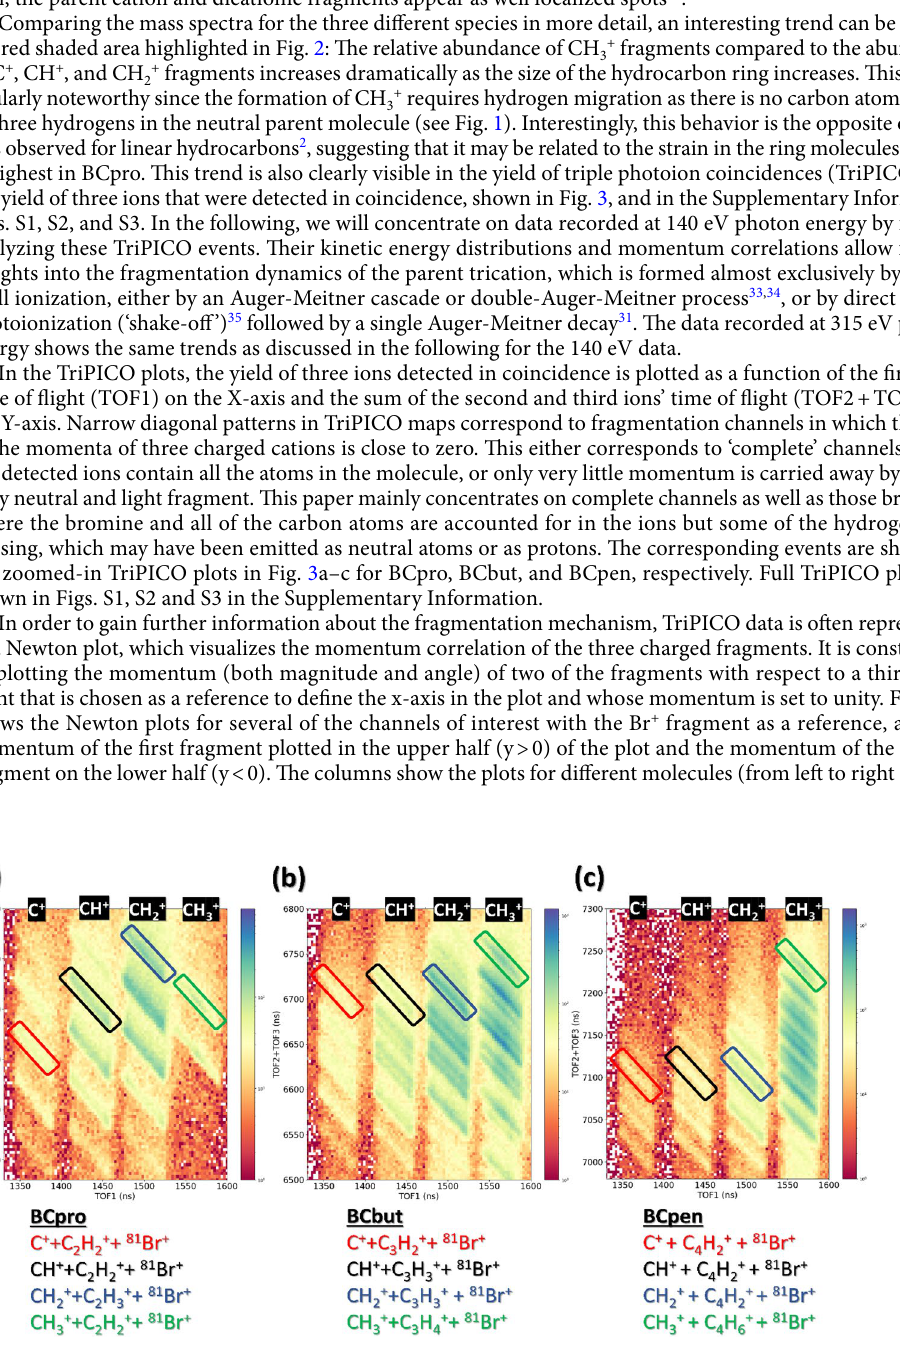
Figure 3. Triple-ion coincidence (TriPICO) plots at 140 eV photon energy for ( a ) BCpro, ( b ) BCbut, and ( c ) BCpen, zoomed-in on the region containing CH x+ fragments (with x = 0, …, 3) detected in coincidence with a Br + fragment and (b) a C 2 H x+ (with x = 0, …, 4 ) fragment, ( c ) a C 3 H x+ (with x = 0, …, 6 ) fragment, and ( d ) a